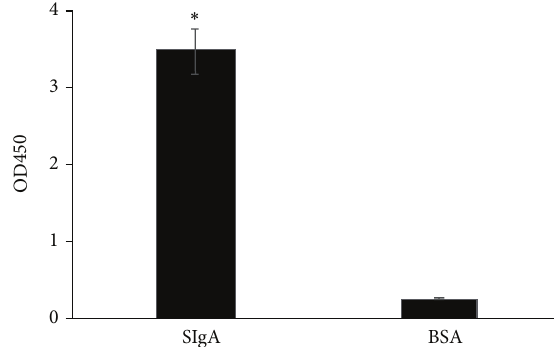
Figure 2: ELISA analysis of H5N1 HA antigen binding capacity of SIgA. H5N1 HA or BSA was coated on 96-well plate as the capture antigens. The produced SIgA was added as the primary antibody, and the secondary antibody was HRP-conjugated goat anti-human IgA. Data were the average of three independent experiments and shown as mean ± SD. Significance was determined by using independent 𝑡 -test ( ∗ 𝑃 < 0.05